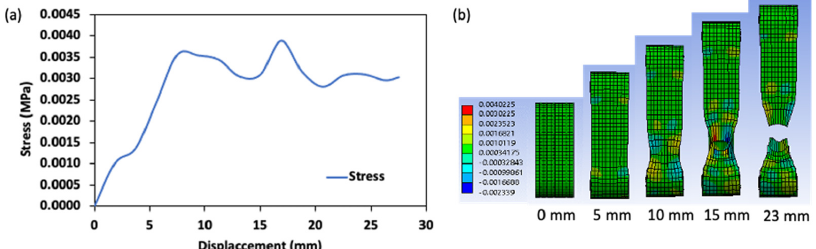
Figure 9. Stress distribution in surimi gel during the ring tensile test; ( a ) quantitative stress value and ( b ) contour description of the stress concentration region.